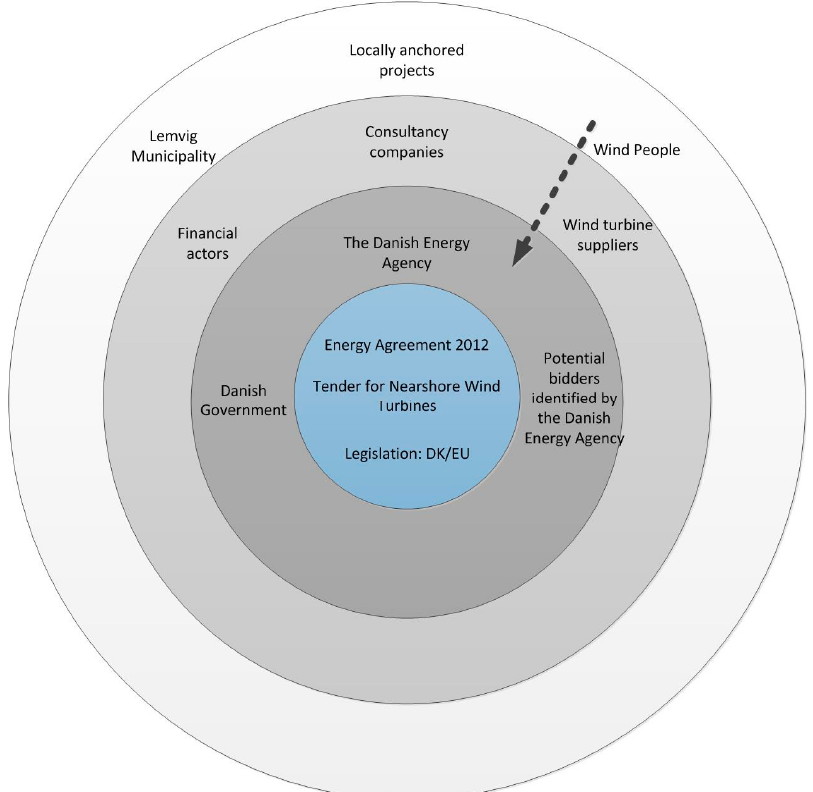
Figure 2. Actors in the tender for 350 MW nearshore wind turbines in Denmark, mapped in relation to how closely they are connected to the Danish Energy Agency and thereby the decision making in the tender process. The closer the actors are placed to the blue inner circle, the more likely they are to be included in the tender process.